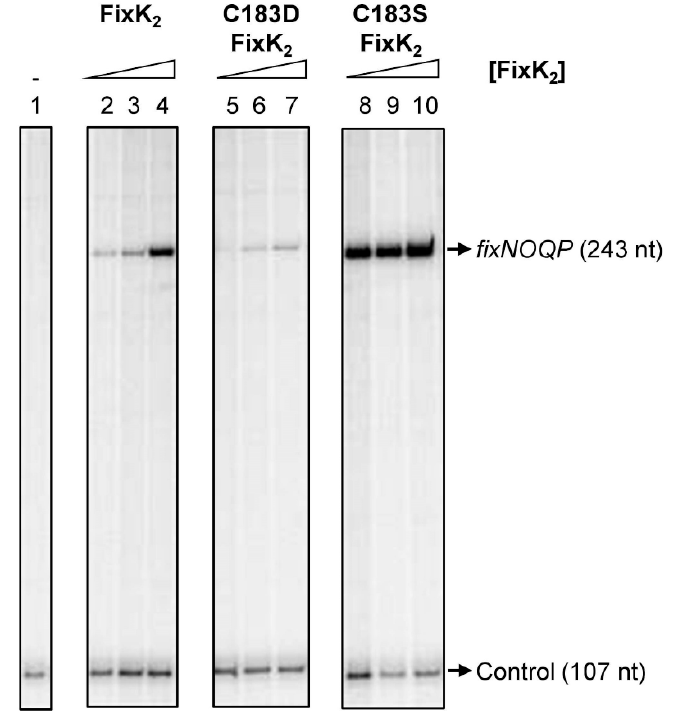
Figure 1. IVT activation from the fixNOQP promoter mediated by different FixK 2 protein deriva- tives. Plasmid pRJ8816 harboring the fixNOQP promoter cloned upstream of the B. diazoefficiens rrn transcriptional terminator was employed as template for multiple-round IVT activation assays with B. diazoefficiens RNAP holoenzyme. A series of concentrations of FixK 2 protein variants were added to the reactions: lane 1, no protein (-); lanes 2, 5 and 8, 0.5 µ M; lanes 3, 6 and 9, 1.25 µ M; lanes 4, 7 and 10, 2.5 µ M. The positions of the fixNOQP transcript and the FixK 2 -independent transcript (used as control for the experiments) are depicted on the right. Each panel refers to different sections of the same gel. Shown are the results of a typical experiment that was performed at least twice. nt, nucleotides.